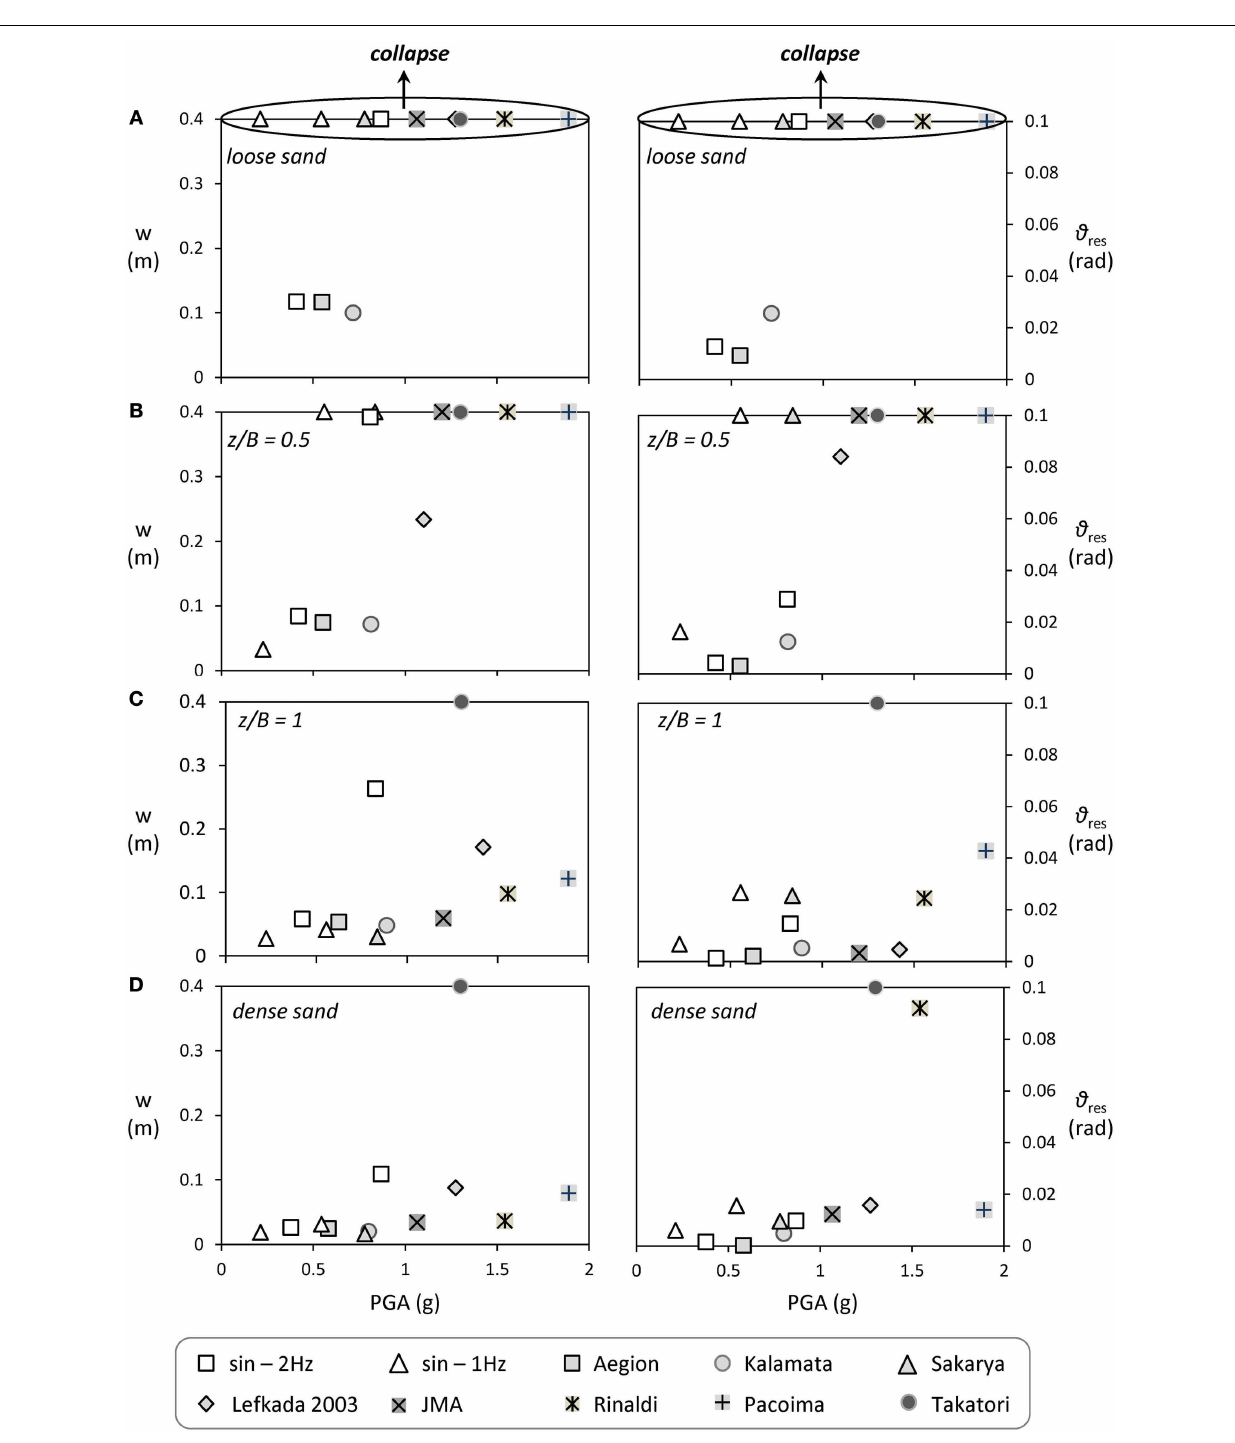
Figure 9C compares the settlement for the two excitation fre- quencies. In the case of dense sand, the settlement is not par- ticularly sensitive to the excitation frequency. The settlement w reaches 2.5 cm for the high-frequency f = 2 Hz sine, being only